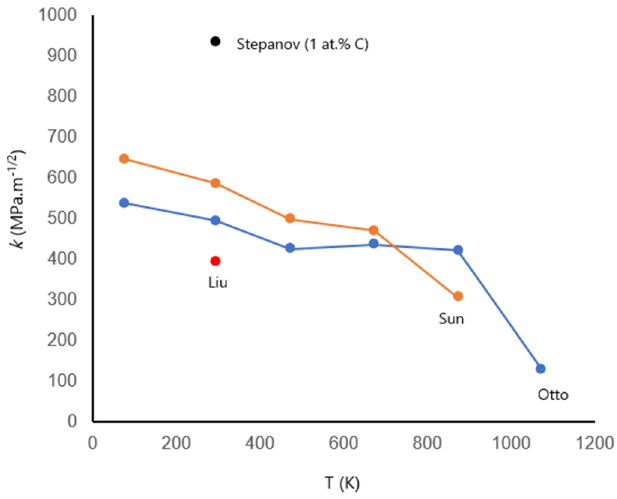
Figure 2. Graph of Hall–Petch parameter, k , versus temperature for undoped equiatomic CoCrFeMnNi, data from [18–20]; and for 1 at. % C-doped CoCrFeMnNi from Stepanov et al. [21].